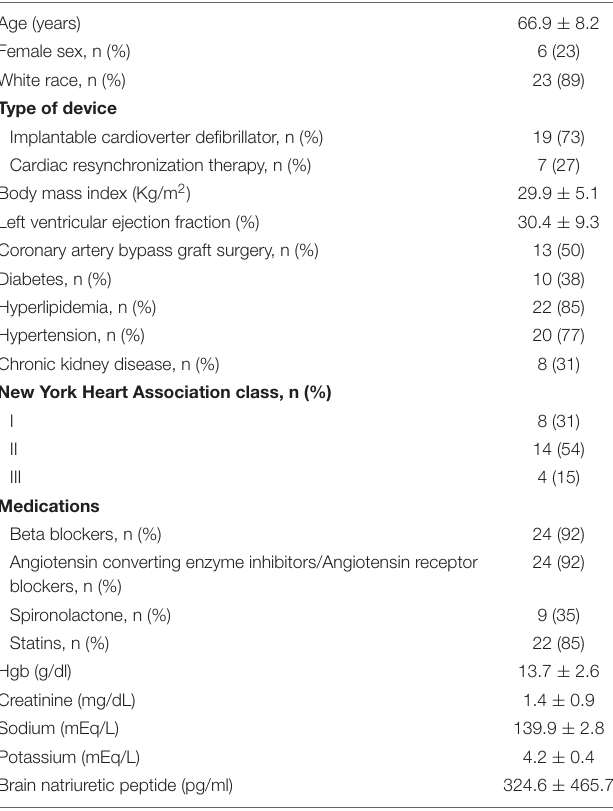
TABLE 1 | Baseline characteristics of the study population ( n =